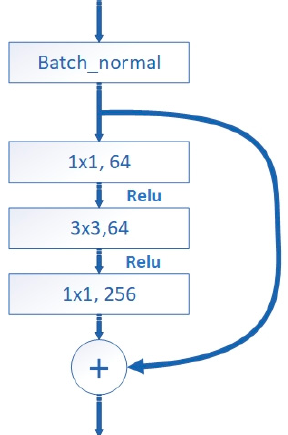
Figure 4. Residual block structure used in this study.